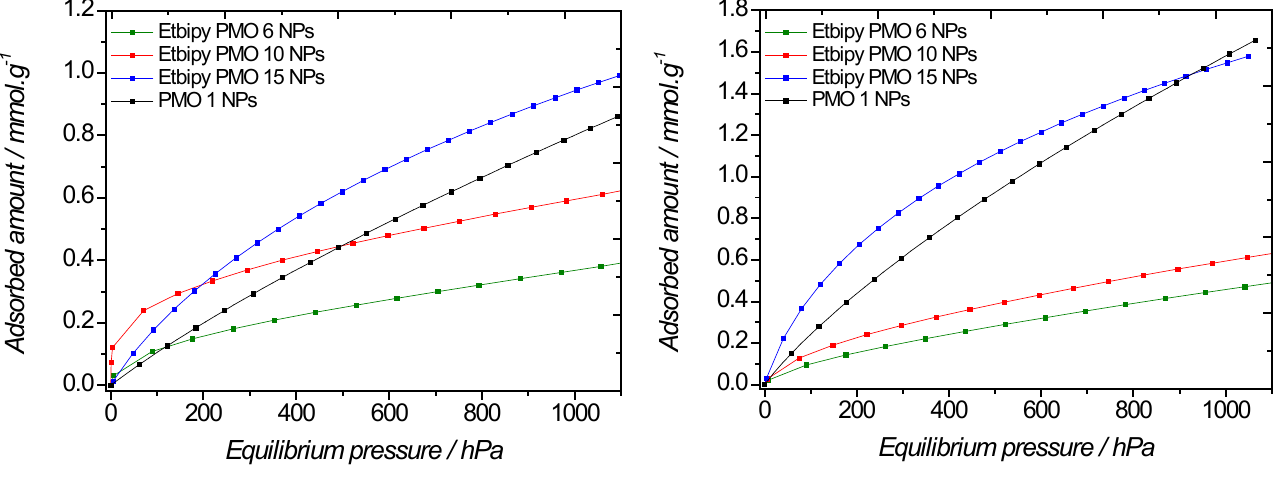
Figure 16. Evolution of the CO 2 adsorption of BTEE/Etbipyridine PMO NPs with different Etbipyridine molar fractions versus absolute pressure at 298 K ( left ) and 273 K ( right ).